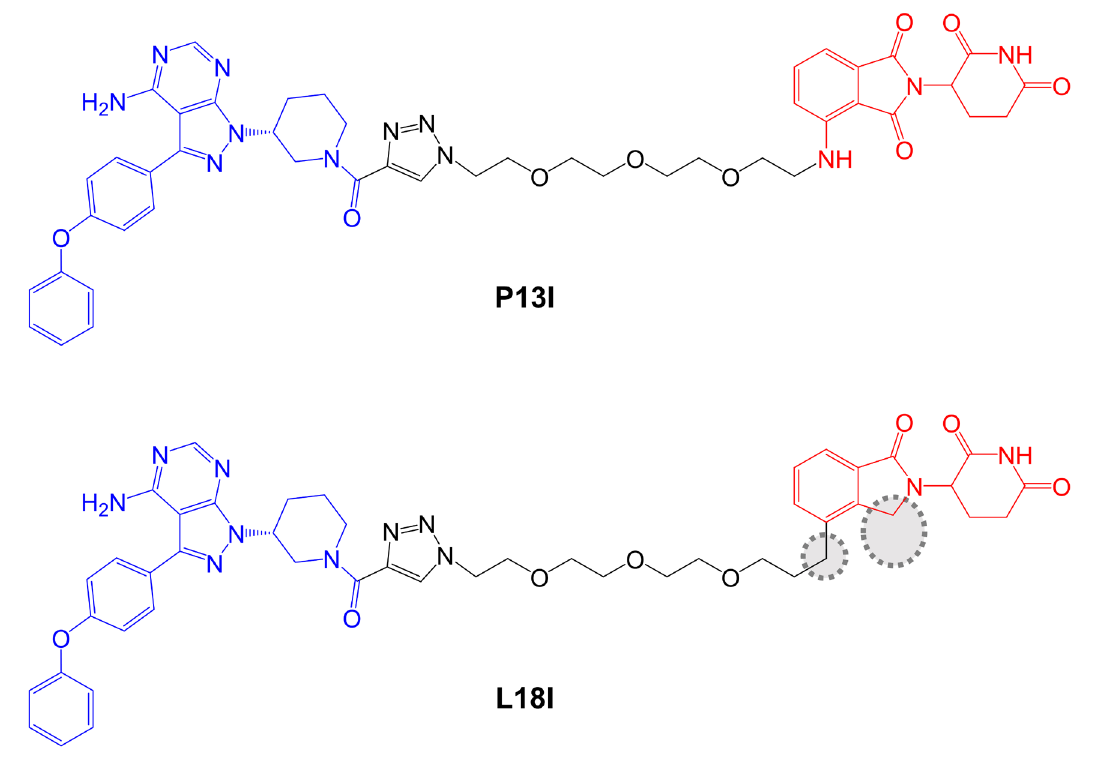
Figure 6. Structures of compounds P13I and L18I. BTK-inhibiting warheads derived from ibrutinib and pomalidomide-derived CRBN-targeting moieties are colored blue and red, respectively [ 89 , 91 ]. Differences in the structure of L18I compared to P13I are highlighted by dotted